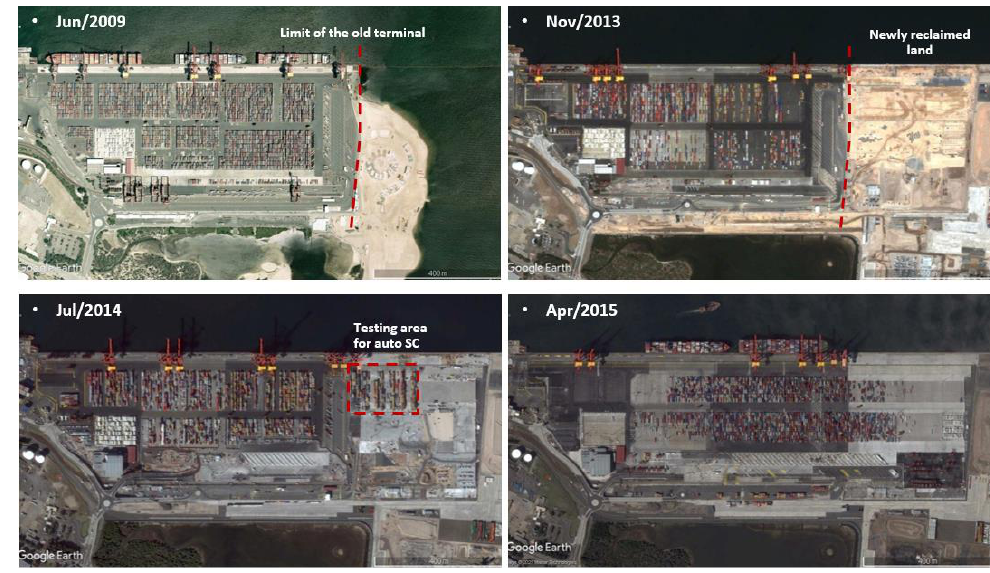
Figure 3. Big bang implementation approach for new automated straddle carriers in the Sydney AutoStrad terminal, Australia.